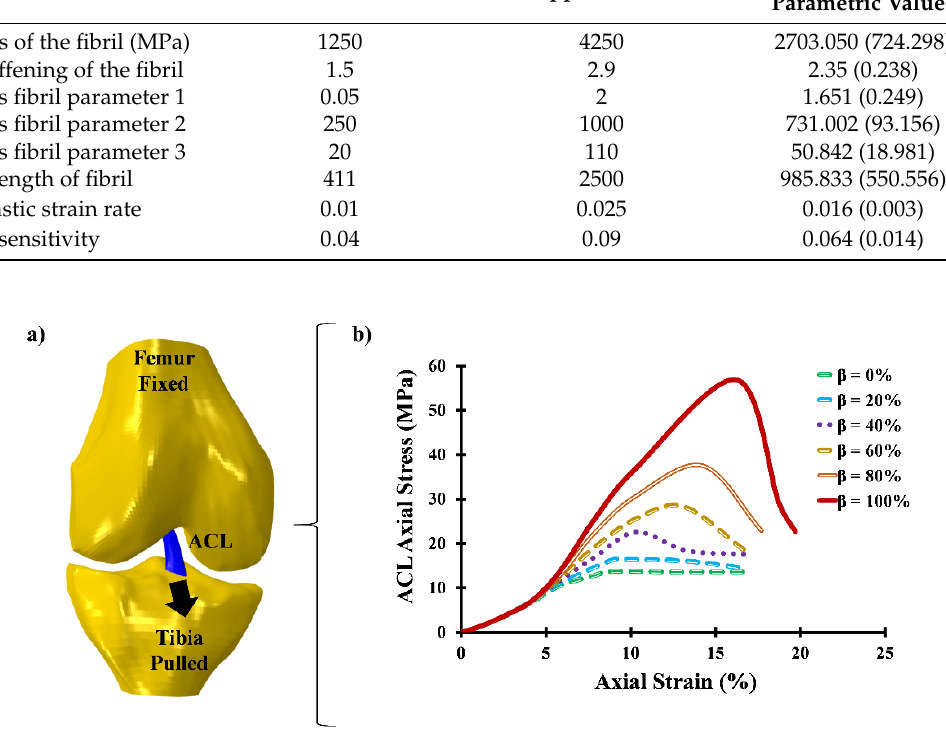
Figure 5. ( a ) Finite-element model of the ACL with the associated boundary conditions considered to simulate the uniaxial tensile test. ( b ) Computed axial maximum stress–strain behavior of the ACL.